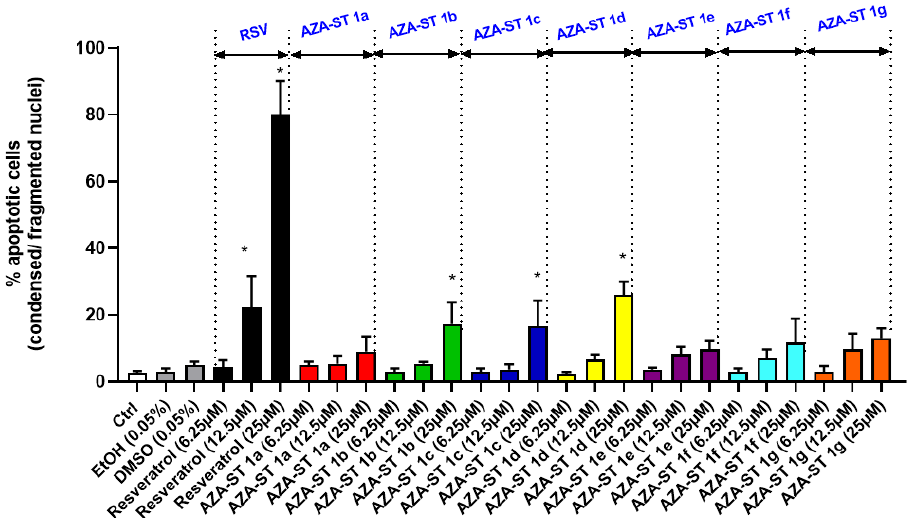
Figure 8. Quantification of apoptotic cells by fluorescence microscopy after nuclei staining with Hoechst 33342: effects of AZA-ST 1a–g and resveratrol on apoptosis induction. N2a cells were incu- bated for 24 h with or without AZA-ST 1a–g or resveratrol (RSV; trans -resveratrol) at concentrations inclosing the IC50s (6.25, 12.5 and 25 µM). Vehicles (Ethanol (EtOH) for RSV; DMSO for AZA-ST) [4]: Ethanol (EtOH; 0.05%) and DMSO (0.05%); the highest concentrations of vehicles were only analyzed. The data are the mean ± standard deviation (SD) of three independent experiments performed in triplicate. The comparison of the data was performed with an ANOVA test followed by a Bonferroni test. (*): p ≤ 0.05 was considered statistically significant.